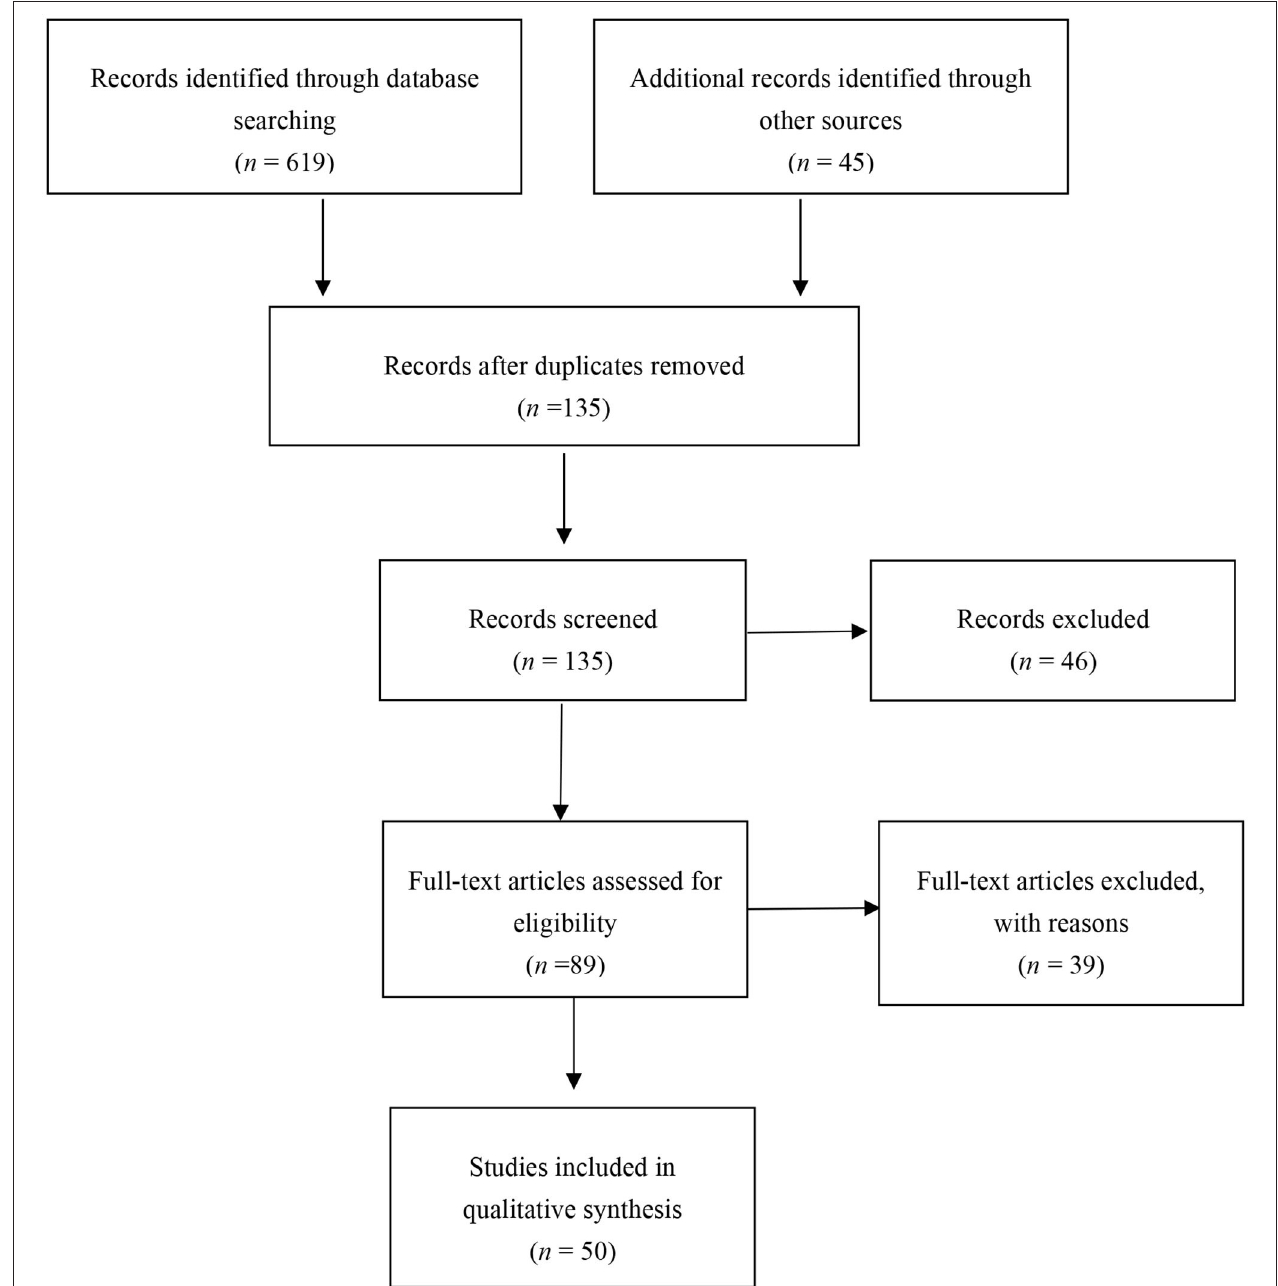
FIGURE 1 | Screening process in accordance with PRISMA